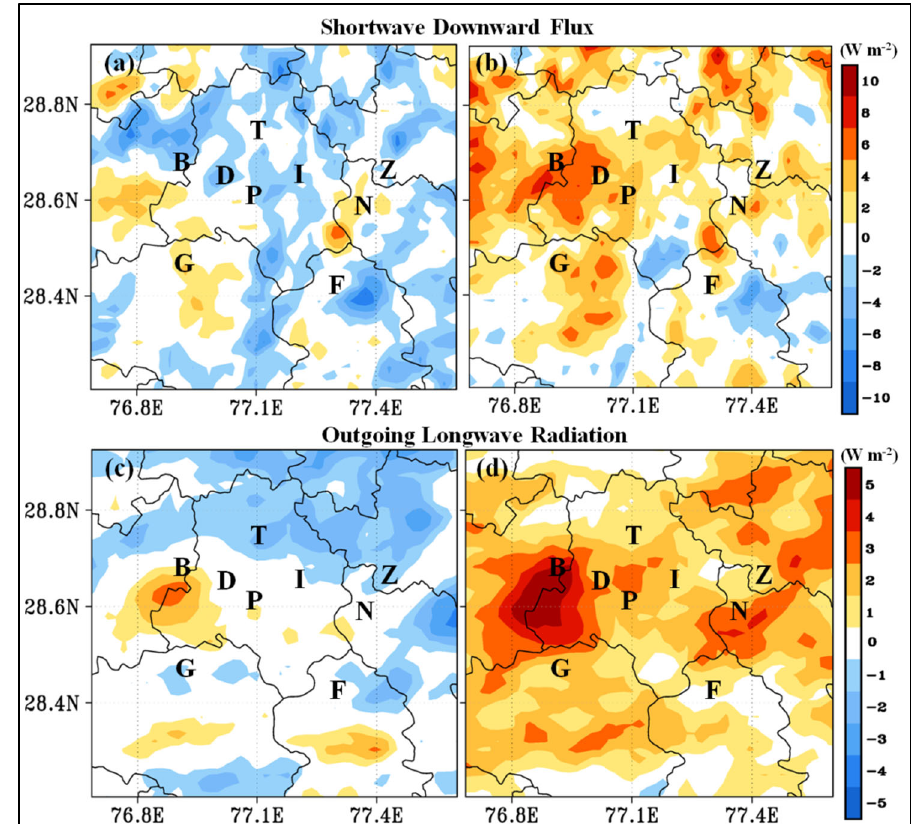
Figure 4. Spatial plots of ( a ) difference of shortwave downward flux (W m − 2 ) between case with direct feedback and no feedback (Case B—Case A). ( b ) Difference of shortwave downward flux (W